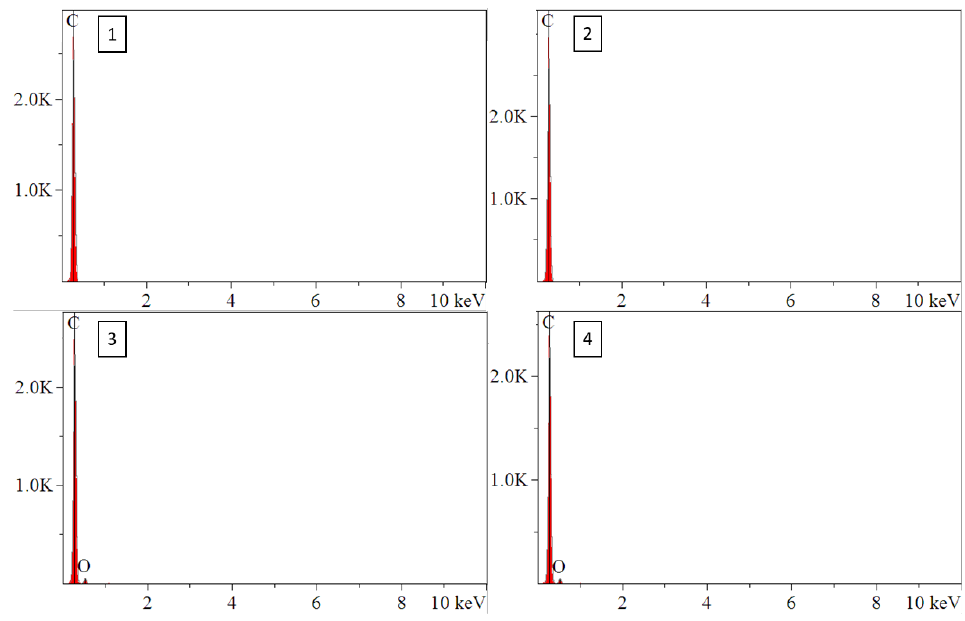
Figure 3. EDS spectra of ABS w/5%CF identifying chopped fibers and oxygen in ABS matrix. Numbers 1 – 4 correspond to the respective areas in Figure 2b.